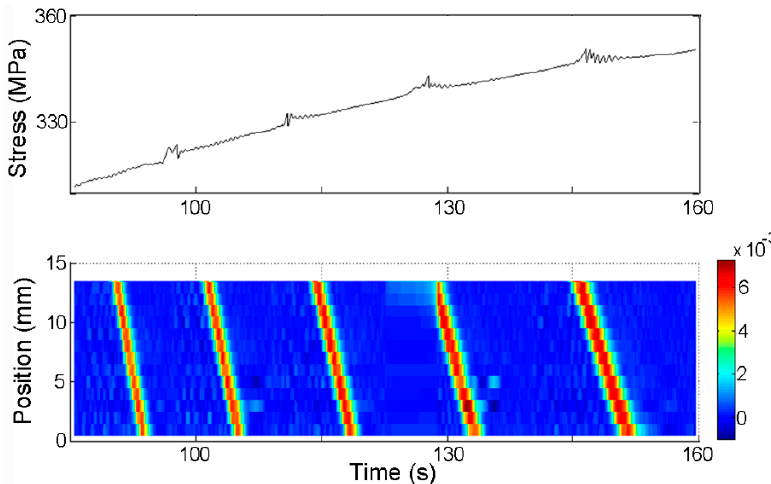
Figure 4. Spatiotemporal pattern showing the time evolution of the local strain rate along the tensile axis of a sample of the coarse-grained (CG) alloy. r a = 10 − 3 s − 1 . Color bar quantifies the local strain-rate scale in s − 1 .